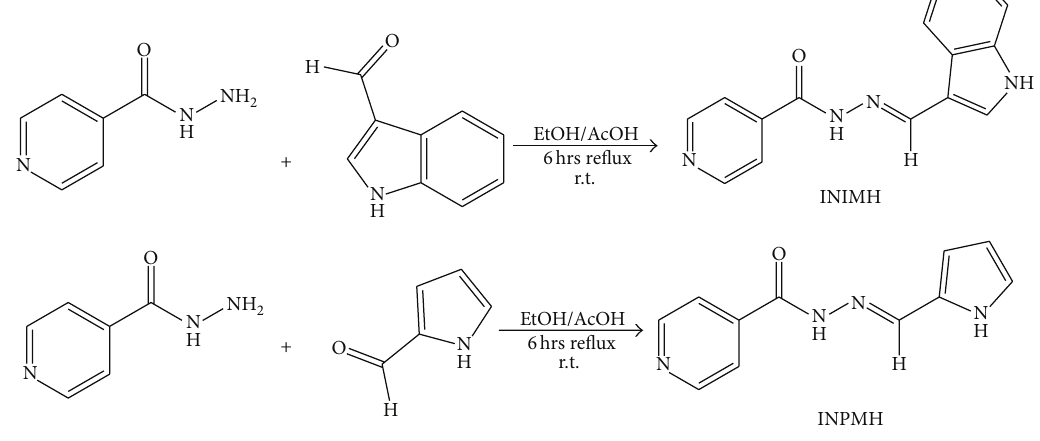
Figure 1: Synthetic schemes of INIMH and